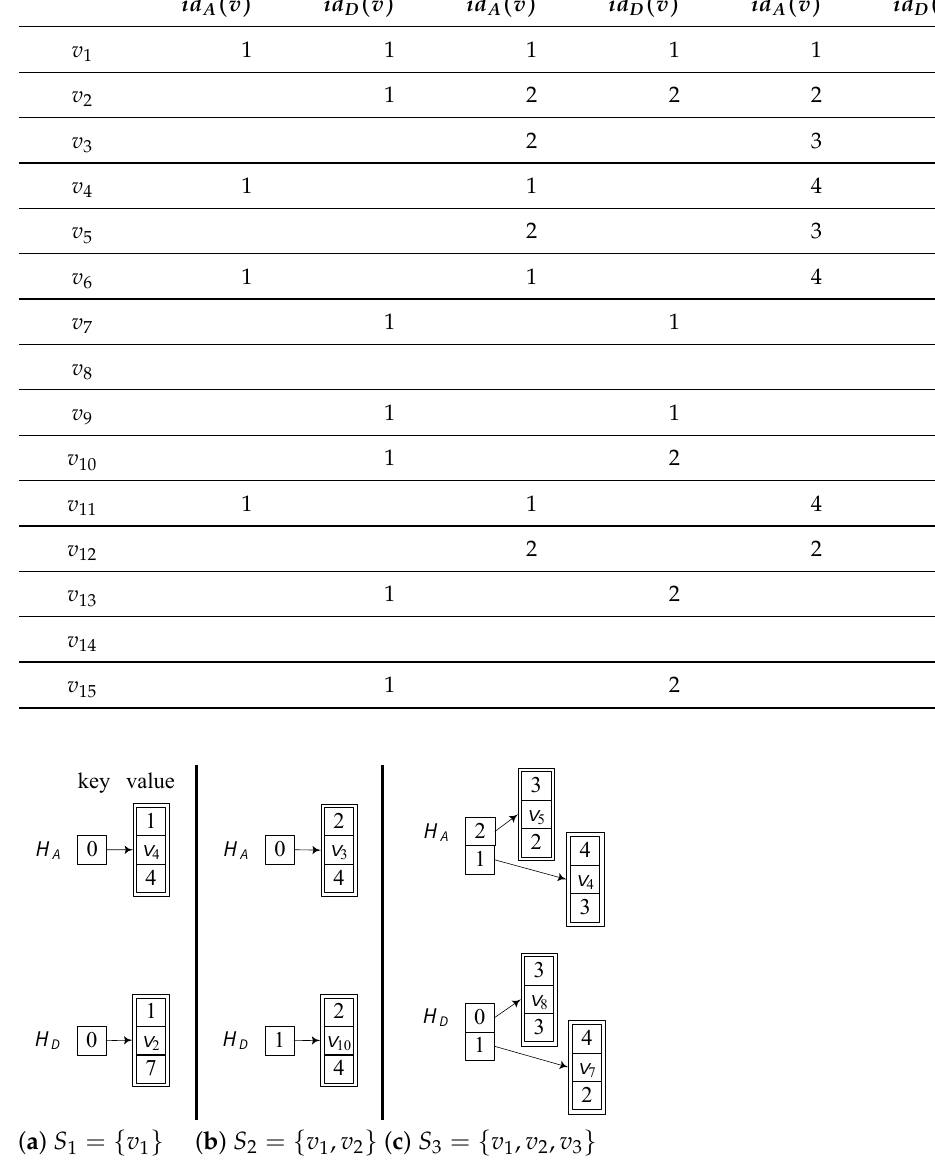
Figure 4. Running status of the two hash tables H